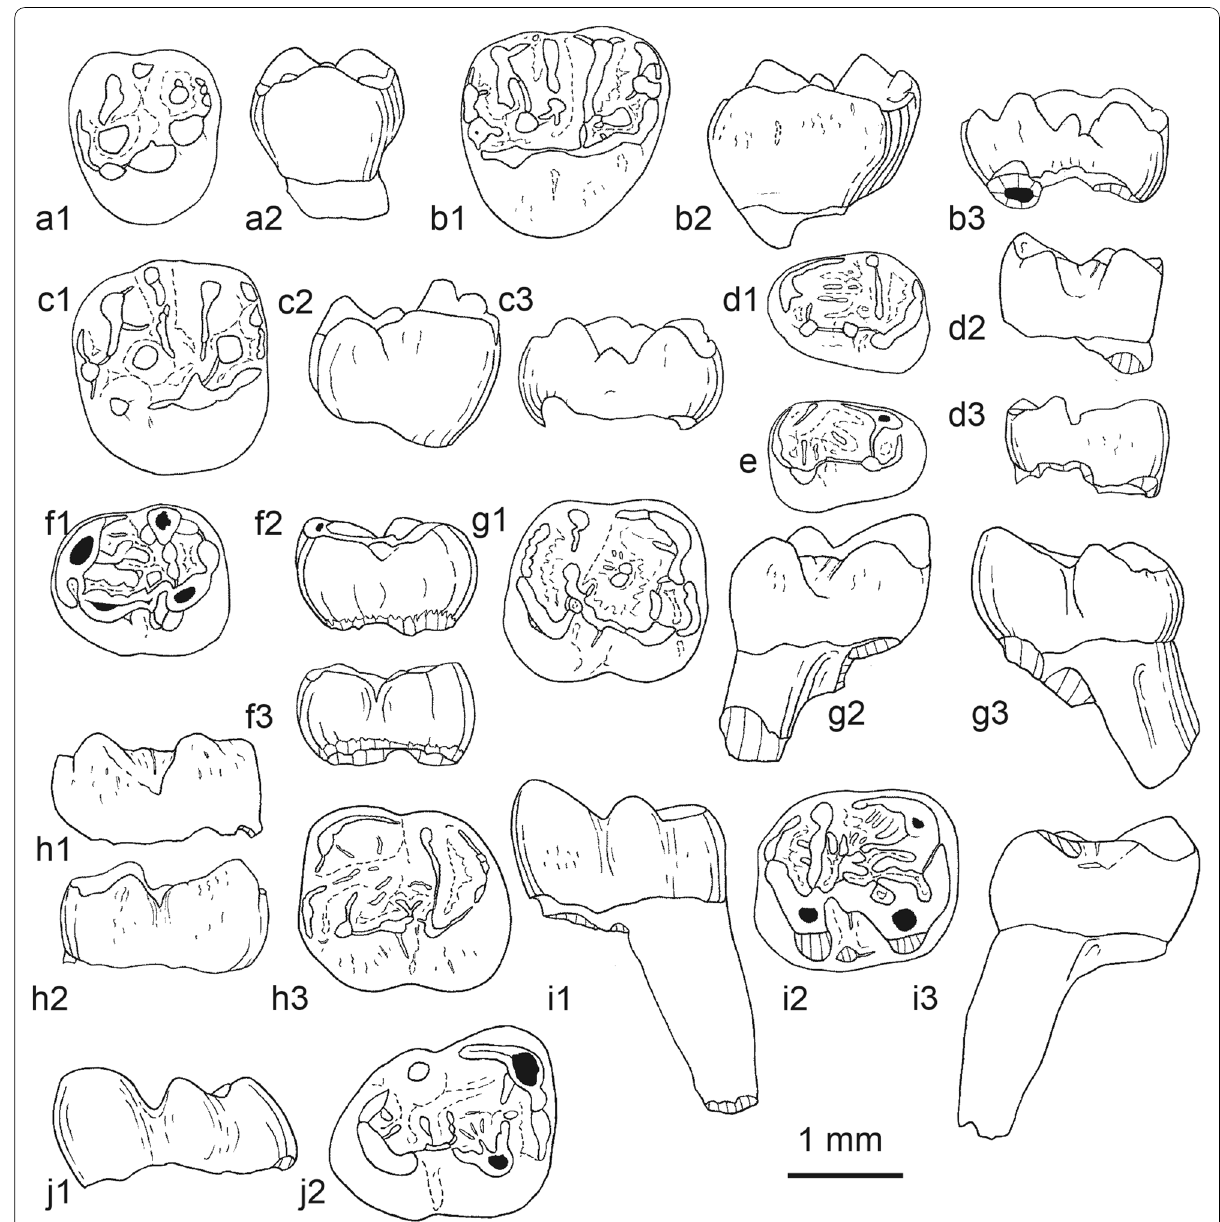
Fig. 38 Teeth of ? Protadelomys cf. alsaticus morphotype 1 from Bouxwiller (Bas‑Rhin). a CSBX8, right P4; a1, occlusal view; a2, lingual aspect. b CSBX35, right M1; b1, occlusal view; b2, lingual aspect; b3, buccal aspect. c : BUX67‑37, right M2; c1, occlusal view; c2, lingual aspect; c3, buccal aspect. d CH25, left dp4; d1, occlusal view; d2, buccal aspect; d3, lingual aspect. e BUX67‑96, right dp4; occlusal view. f CH18, left p4; f1, occlusal view; f2, buccal aspect; f3, lingual aspect. g BUX67‑121 right m2; g1, occlusal view; g2, buccal aspect; g3, lingual aspect. h BUX67‑138, left m2; h1, occlusal view; h2, buccal aspect; h3, lingual aspect. i BUX67‑139, right m2; i1, lingual aspect; i2, occlusal view; i3, buccal aspect. j : BUX68‑23, right m3; j1, lingual aspect; j2, occlusal view. Scale bar 1 =